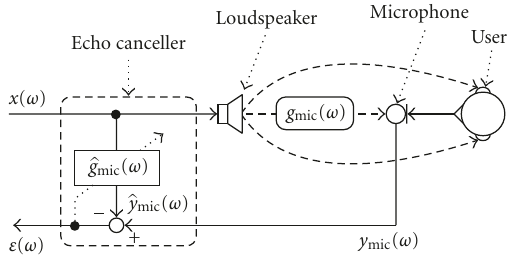
Figure 1: Configuration of acoustic echo canceller in spoken dia- logue